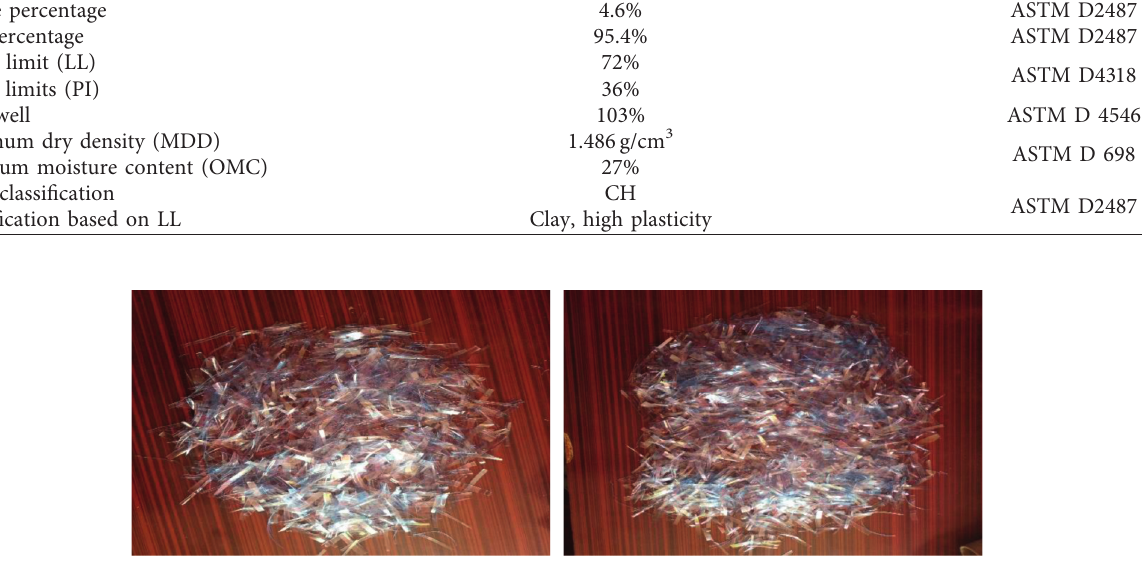
Figure 1: Plastic strips.